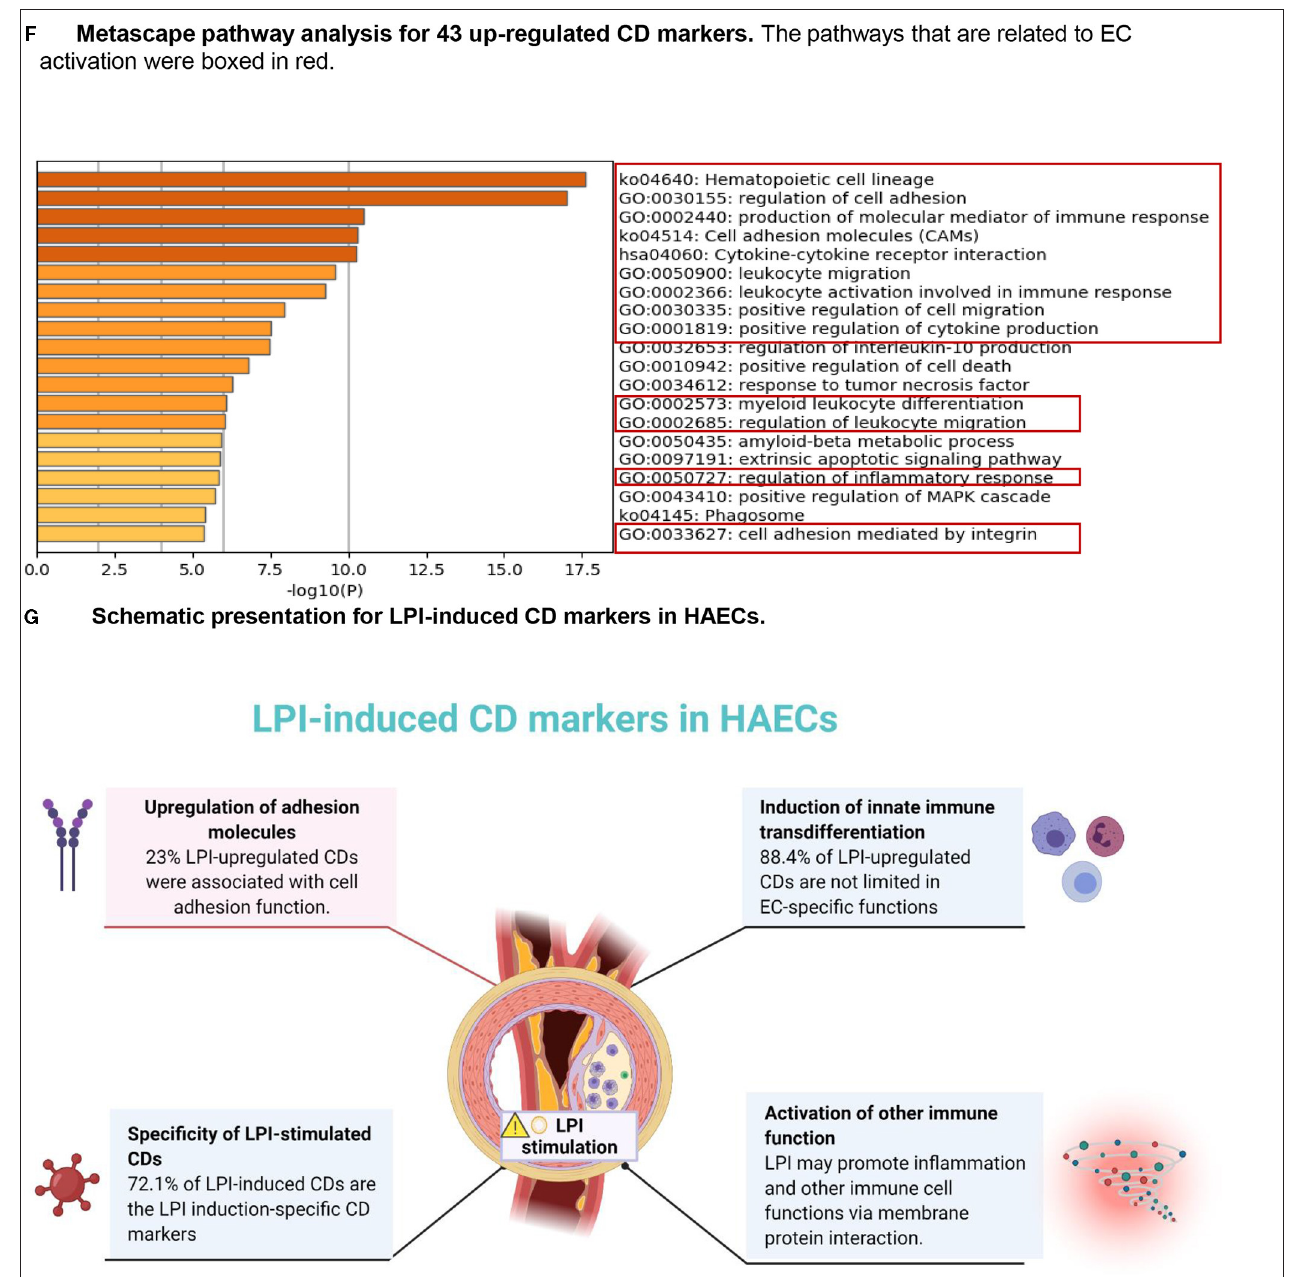
FIGURE 3 | LPIs upregulated EC adhesion molecules and cluster of differentiation (CD) marker-mediated signaling pathways. (A) 373CD markers were used for database mining. Genes with p < 0.05 and log 2 FC > I1I were selected as significantly changed genes. The total number of significantly changed CD markers is 65; upregulated genes account for 66.2% (43/65) and downregulated genes occupied 33.8% (22/65). Downregulated CDs can be found in Supplementary Table S1 . (B) Eighteen out of 43 LPI-induced CDs mediate EC adhesion, immune cell responses, and inflammatory cell signaling. (C) Twenty-five out of 43 LPI-induced CDs mediates the other cell signaling. (D) One hundred fifty-nine endothelial cell-specific markers were generated (modified from PMID: 29333215). The LPI-upregulated EC-specific genes were compared with the upregulated CD markers. The Venn diagram indicated that five adhesion molecules showed in the overlapped area between endothelial cell-specific cell markers and LPI-stimulated CD markers. The functions of five overlapped CD markers and most of them participate in the cell adhesion process. (E) About 43 upregulated CDs were screened in seven virus-stimulated EC datasets (PMID:34248940). Sixteen out of 43 showed different changes in these seven datasets. (F) Upregulated genes of LPI-treated HAECs were analyzed by Metascape (https://metascape.org/gp/index.html#/main/step1). Pathways with high expression are related to the cell adhesion process, leukocyte migration, and inflammation. (G) A schematic presentation shows how LPIs regulate endothelial cells by mediating membrane protein interactions. *(G) was created with Biorender.com.